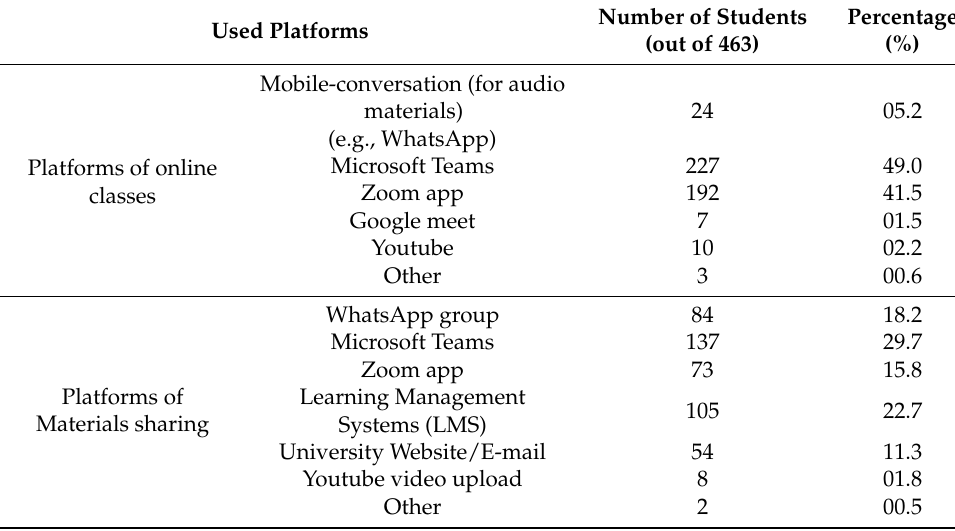
Table 6. Used platforms for learning and material